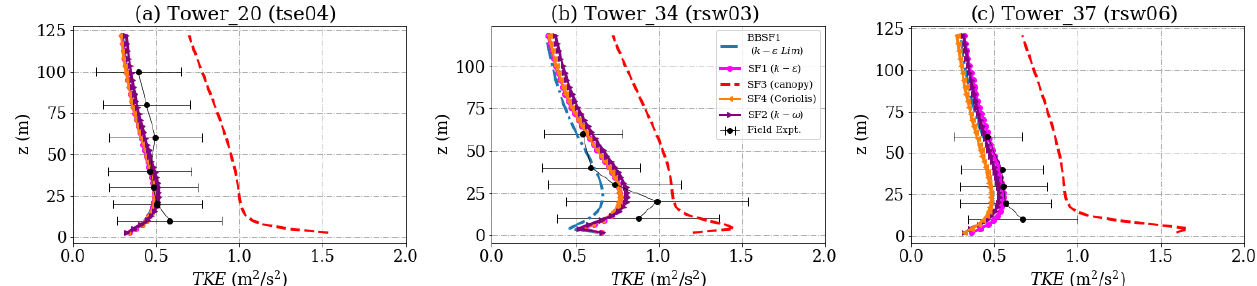
Figure 7. Simulation results and experimental data for turbulent kinetic energy on the southwest ridge for (a) Tower 20 (tse04), (b) Tower 34 (rsw03) and (c) Tower 37 (rsw06). The locations of the masts are given in Fig. 2.